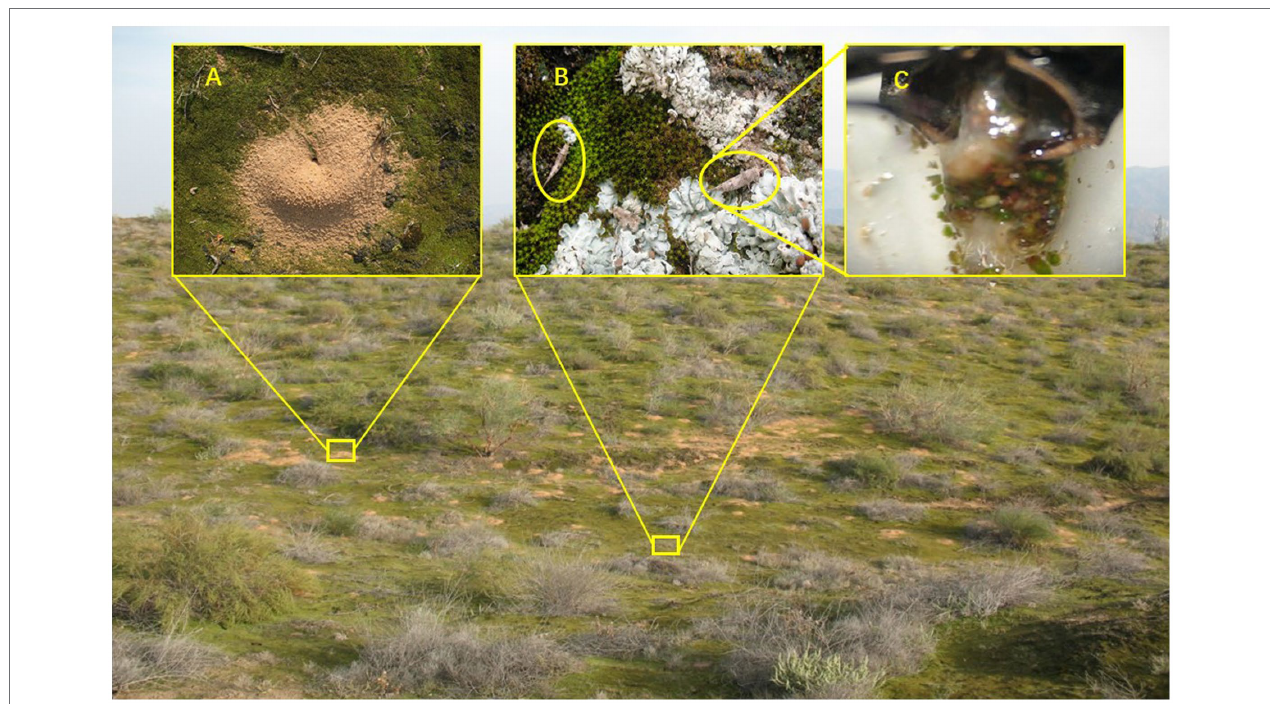
FIGURE 3 | Biocrust provided both a novel habitat and food source for soil arthropod [ (A) numerous ant nest occurred on biocrust covered dune surface; (B) Haslundichilis sp. were feeding on lichen and moss; and (C) moss and lichen were found in Haslundichilis sp.